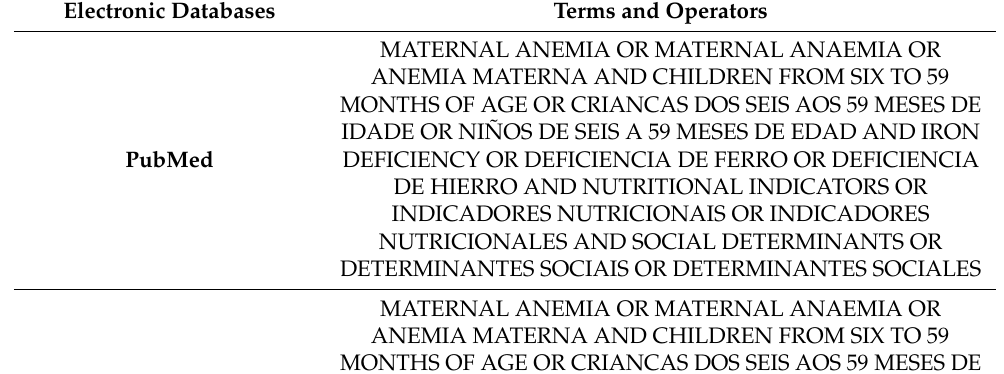
Table 1. Search terms and operators used for the identification of publications in the electronic